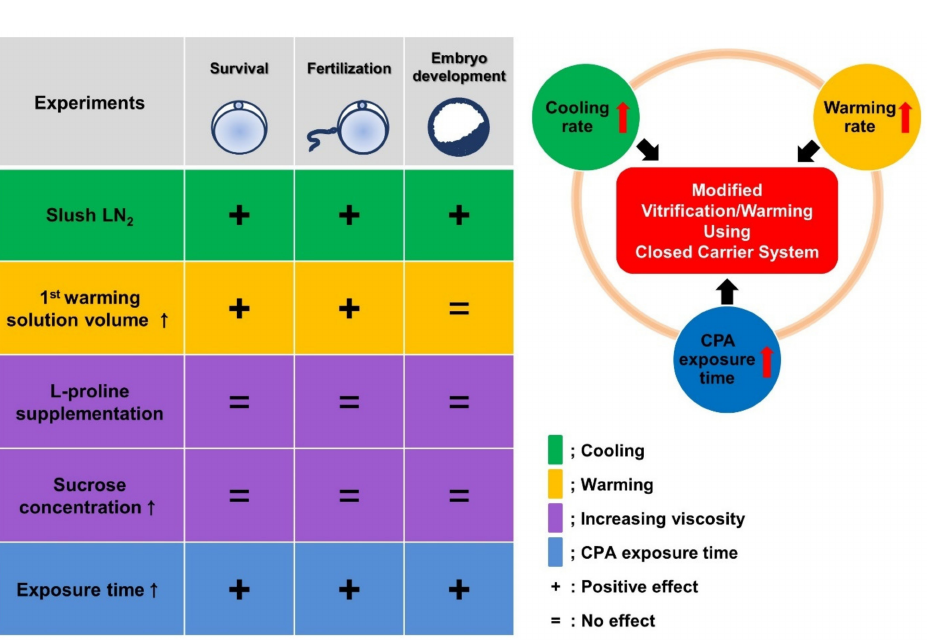
Figure 8. Schematic illustrations that summarize the outcome of the modified key parameters in the conventional closed carrier system (CC). Each color indicates a parameter that was modified, and ↑ , +, and = represent an increase, a positive effect, and no effect,